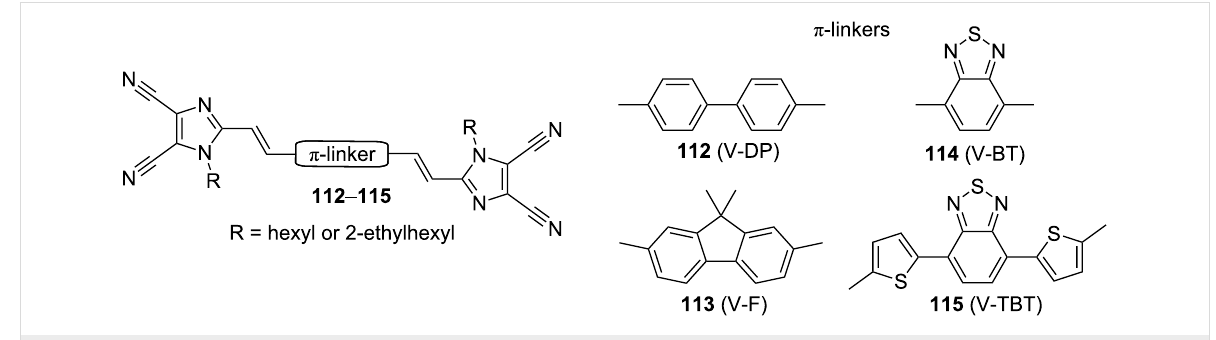
Figure 20: Diimidazoles 112 – 115 used as small electron acceptors in organic solar cells [115,116].